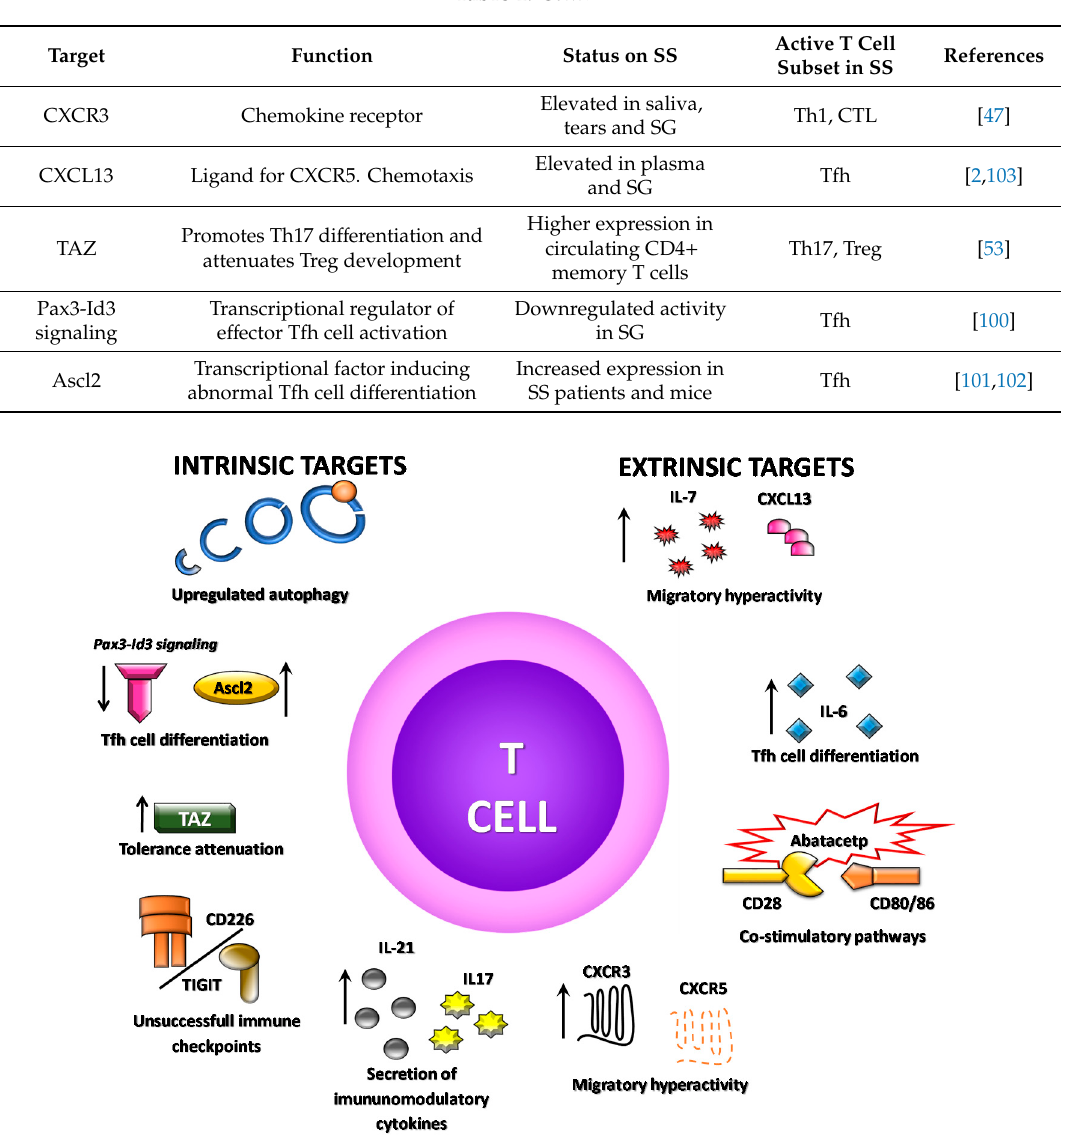
Figure 2. Schematic representation of the several potential T cells alternative targets for SS therapeutic. Novel biomolecules are arising as key factor for controlling several aspects of T cells immunobiology, encompassing those directed towards their activation and migratory sate, as well as those implicated in modulating their inflammatory phenotype.